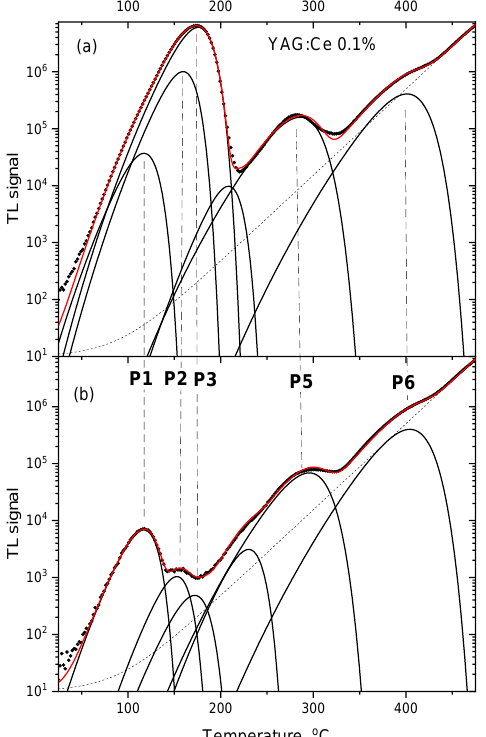
Figure 9. TL glow-curves of YAG:Ce 0.1% crystal, deconvoluted into single peaks. ( a ) no IR illumi- nation, ( b ) after 2000 s of IR illumination. Dose 2 Gy.